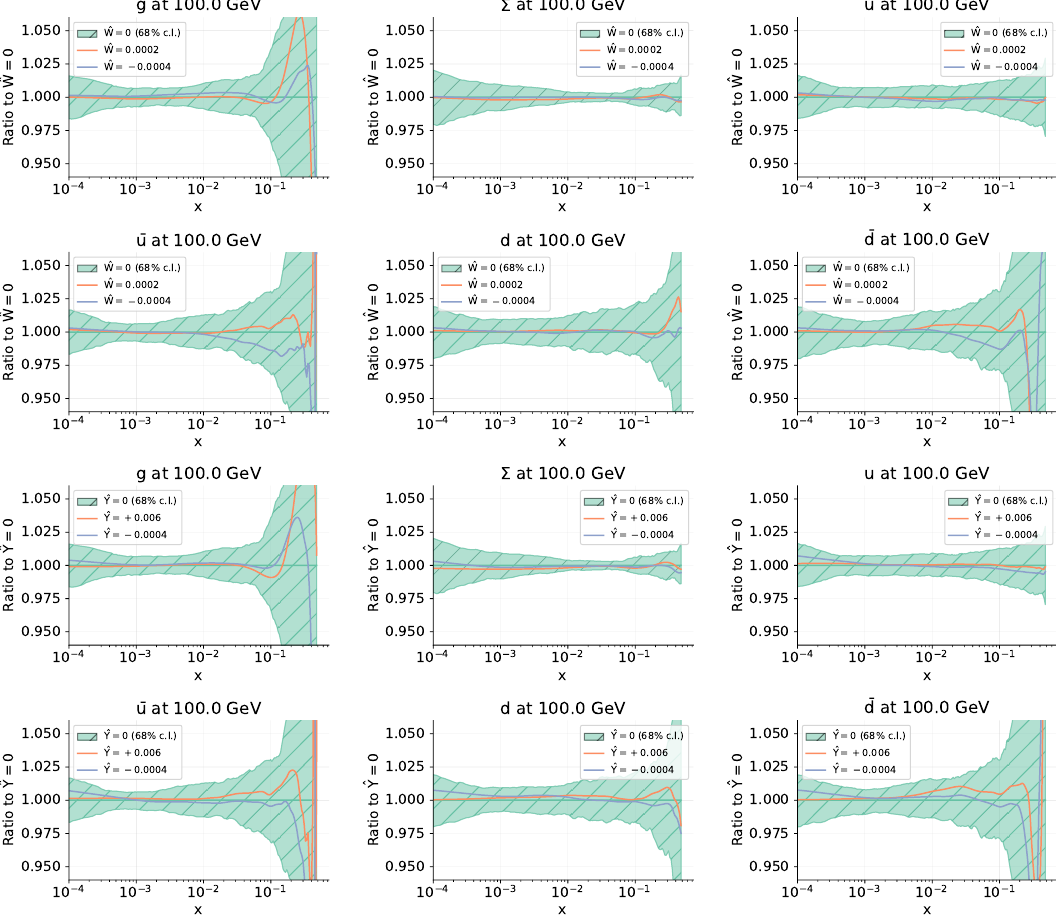
Figure 31 . Comparison between the SM and the SMEFT PDFs at Q = 100 GeV, displayed as ratios to the central value of the SM PDFs, for representative values of the ˆ W (upper) and of ˆ Y (lower panels) parameters. We show the gluon, the total quark singlet, the up quark and antiquark, and the down quark and antiquark PDFs. The values of ˆ W and ˆ Y are chosen to be close to the upper and lower limits of the 68% CL intervals reported in table